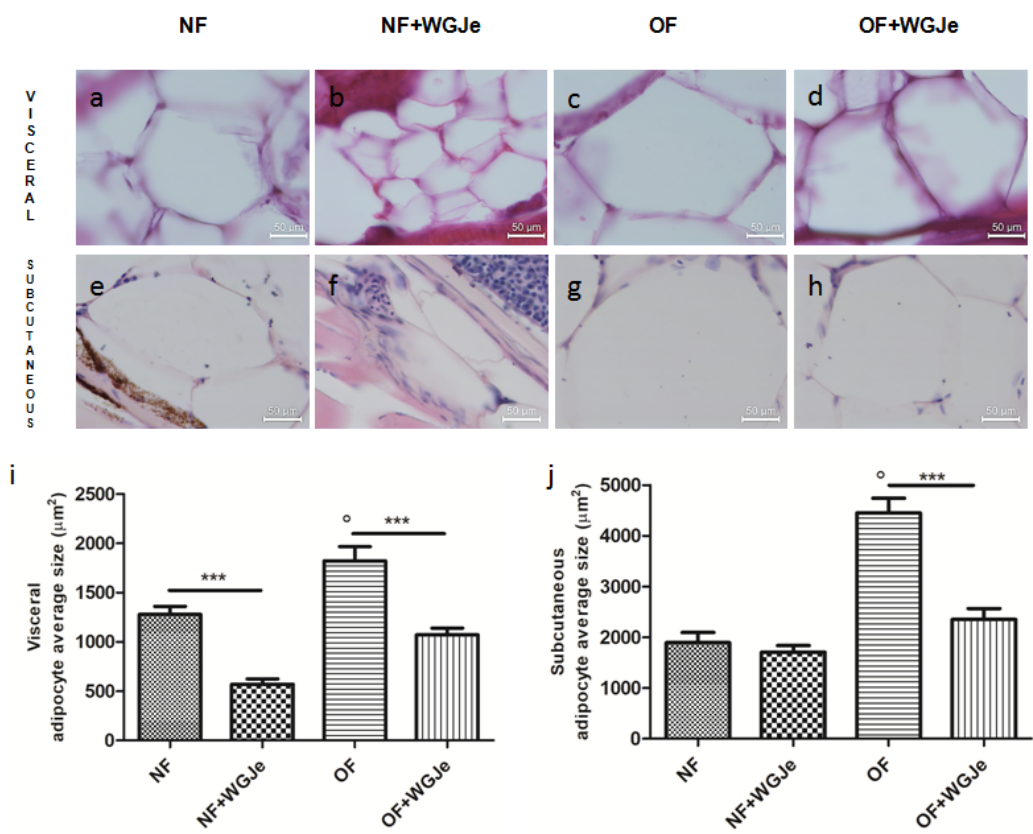
Figure 4. Outcomes of WGJe on visceral and subcutaneous adipocyte size. Histological confirmation (hematoxylin and eosin staining) of fat in the different experimental groups showing visceral ( a – d , i ) and subcutaneous ( e – h , j ) adipocyte size. The treatment with WGJe, particularly in OF group, reduced significantly in both visceral ( d , i ) and subcutaneous ( h , j ) tissues the average size of adipocytes. The photomicrographs ( a – h ) are representative of those (three per section) taken in 10 fish per group. The bar graphs show the results of the morphometric analysis of average adipocyte size in both visceral ( i ) and subcutaneous ( j ) tissue of the four experimental groups. Scale bars are 50 µ m. Results from the morphometric analysis in graphs ( i , j ) are expressed in µ m 2 of adipocyte size and expressed as mean ± SD with n = 15 fish per group. *** p < 0.001 vs. respective counterparts; ◦ p < 0.001 vs. NF.